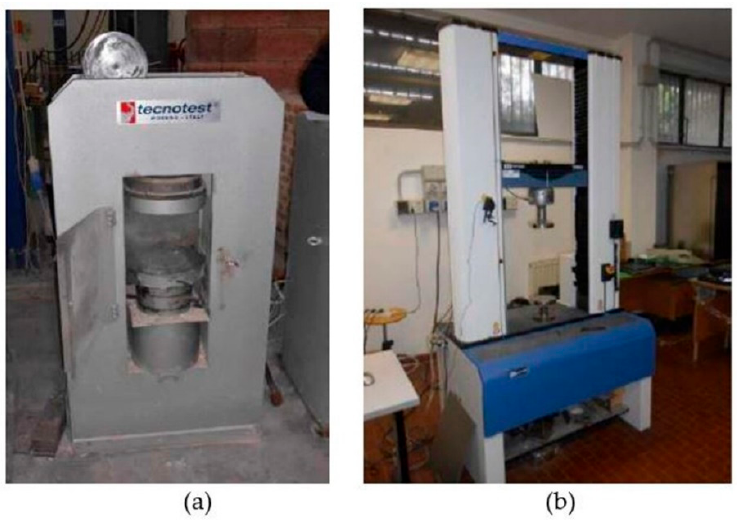
Figure 9. KE series Tecnotest compression machine with maximum load 2000kN ( a ) and model 3382 Instron traction/compression machine with maximum load 100kN ( b ).